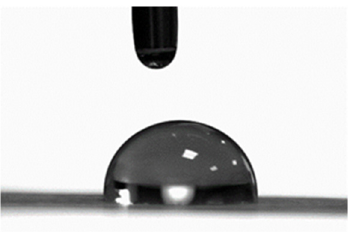
Figure 10. Oil contact angle of fluorinated paper